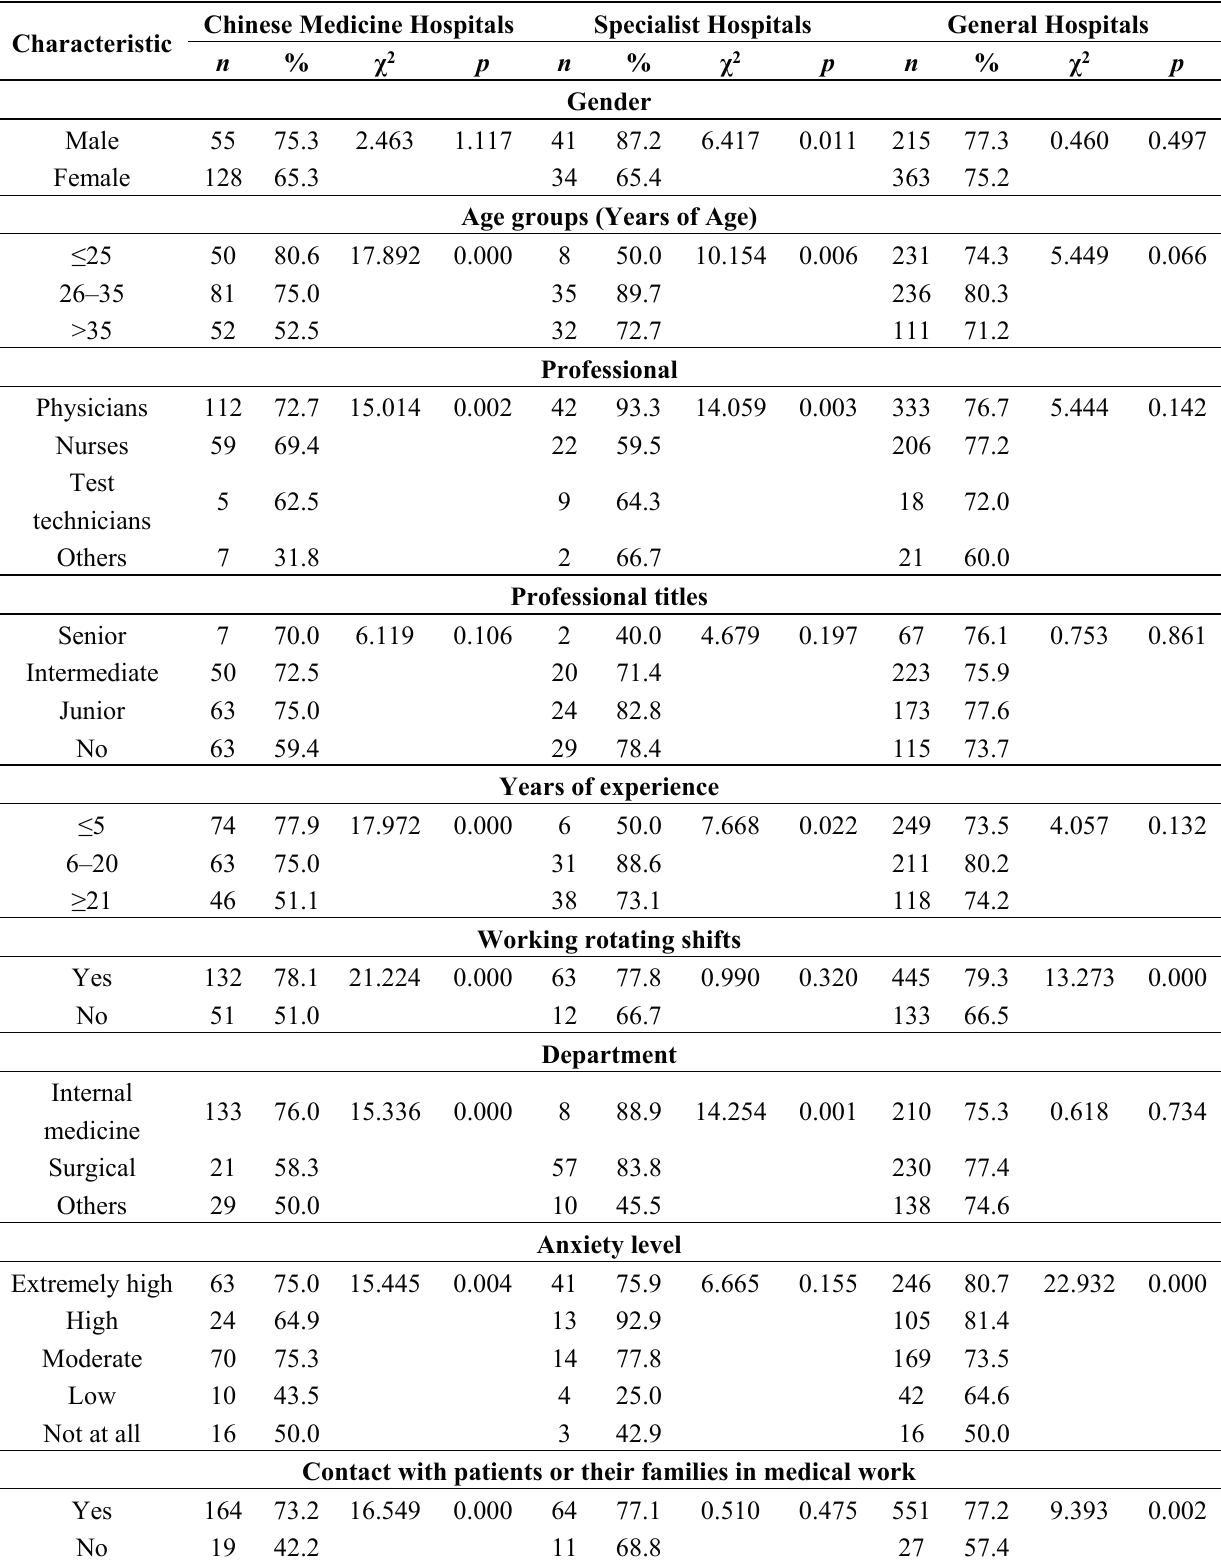
Table 4. Characteristics and frequency distributions for non-physical violence ( N = 1129).